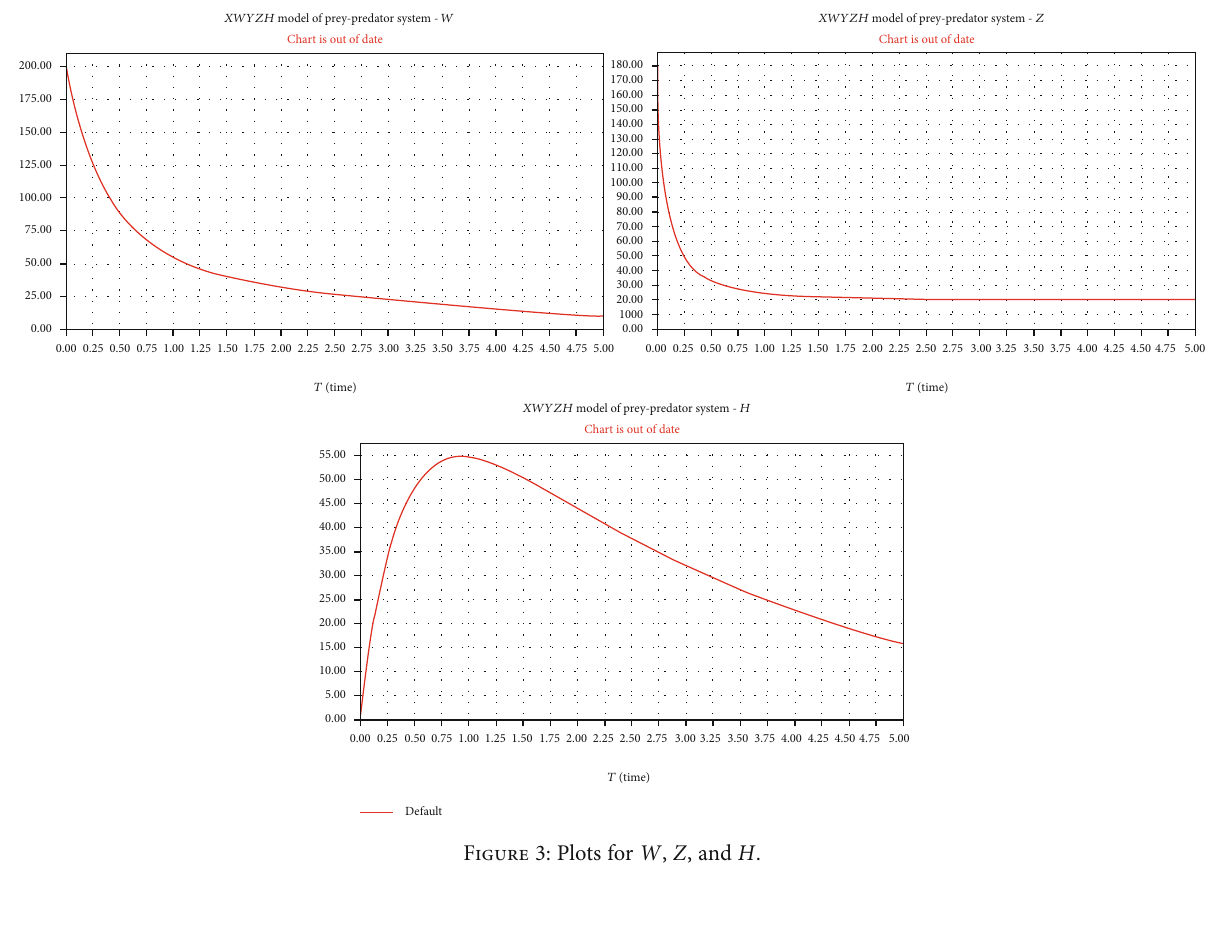
Figure 2: Infected prey-predator with treatment.